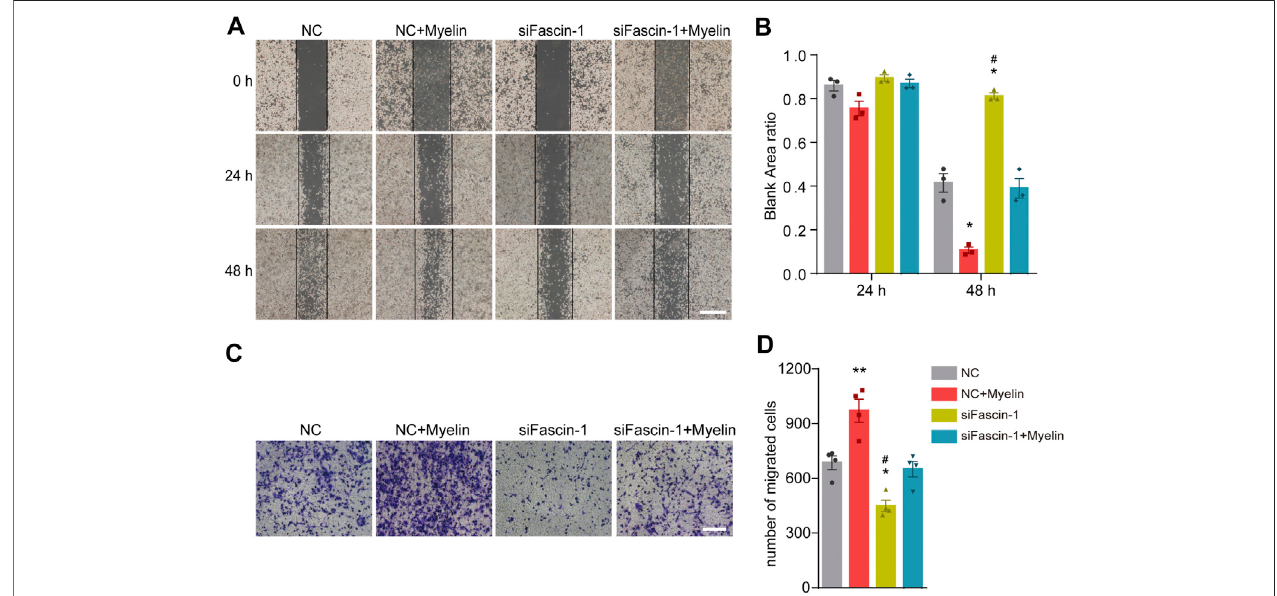
FIGURE6| Fascin-1promotesthemigrationofmicroglia invitro . (A) Forthescratchassay,cellmigrationwasrecordedat0,24and48 hafterscratching(n (cid:2) 3per group). BV-2 cells were transfected with nonspeci fi c control (NC) or Fascin-1 (siFascin-1) siRNA for 24 h and treated with or without myelin for an additional 24 h in complete medium. Scale bar: 2 mm. (B) Quanti fi cation of the ratio of the blank area in the scratch migration assay. The results are presented as the mean ± SEM of experimentsconductedintriplicate.* p < 0.05(NC+MyelinorsiFascin-1vsNC); # p < 0.05(NC+MyelinvssiFascin-1). (C) Transwellassayswereusedtodetectthe migration of microglia. BV-2 cells were treated as described in (A) . After 48 h, the cells were resuspended in serum-free media and added to the upper chamber. Then, thecellswereallowedtomigrate foranadditional 12 handstainedwithcrystalviolet.Scalebar:200 μ m. (D) Quantitative analysisofthenumberoftransmembrane cells in (C) ( n (cid:2) 4 per group). The results are presented as the mean ± SEM. ** p < 0.01 (NC + Myelin vs NC), * p < 0.05 (siFascin-1 vs NC). # p < 0.05 (siFascin-1 vs siFascin-